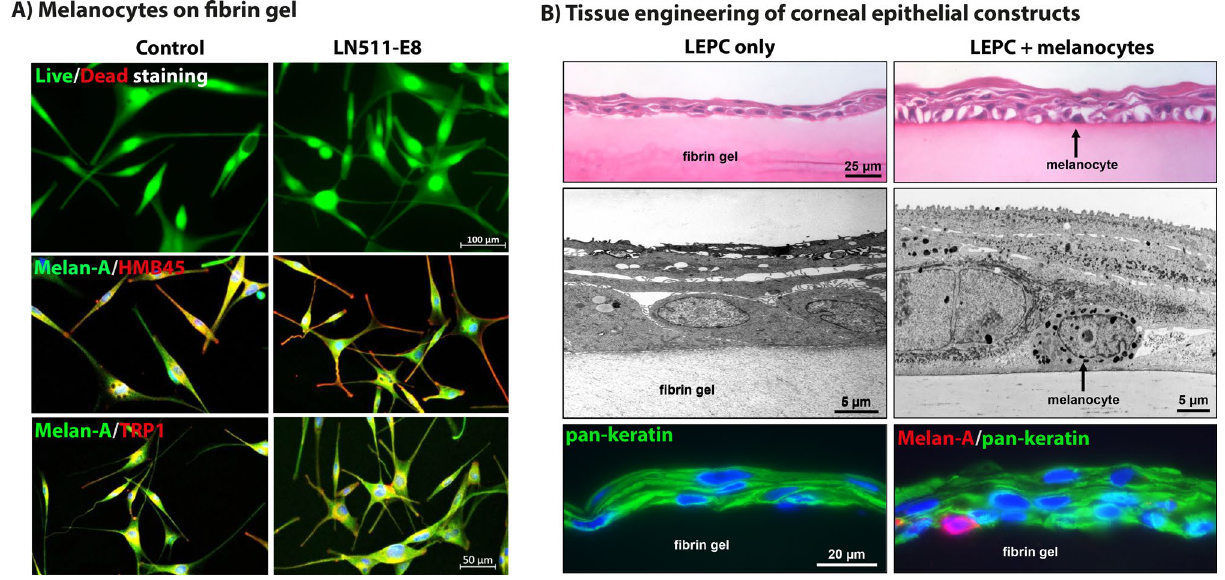
Figure 4. Corneal epithelial tissue engineering using limbal melanocytes and LN-511-E8. ( A ) Live/dead viability assay and immunofluorescence double labeling studies after 24 h of cultivation of limbal melanocytes on fibrin hydrogels pretreated with LN511-E8 or untreated fibrin gels (control). In both conditions, cells are viable and co-express melanocyte markers Melan-A (green) in association with HMB-45 and tyrosinase related protein 1 (TRP1) (red), respectively; nuclear counterstaining with 4 ′ ,6 ‐ diamidino ‐ 2 ‐ phenylindole (DAPI, blue). ( B ) Light microscopic analysis of fibrin-based epithelial constructs formed by limbal epithelial progenitor cells (LEPC) without or with co-cultured melanocytes after 10 days of cultivation (top). Transmission electron microscopy images of epithelial constructs without or with basally located melanocytes (center). Immunofluorescence analysis of epithelial constructs showing epithelial cells positive for the epithelial marker pan-keratin (green) in association with Melan-A-positive melanocytes (red) localized within the basal cell layer (bottom); nuclear counterstain with DAPI